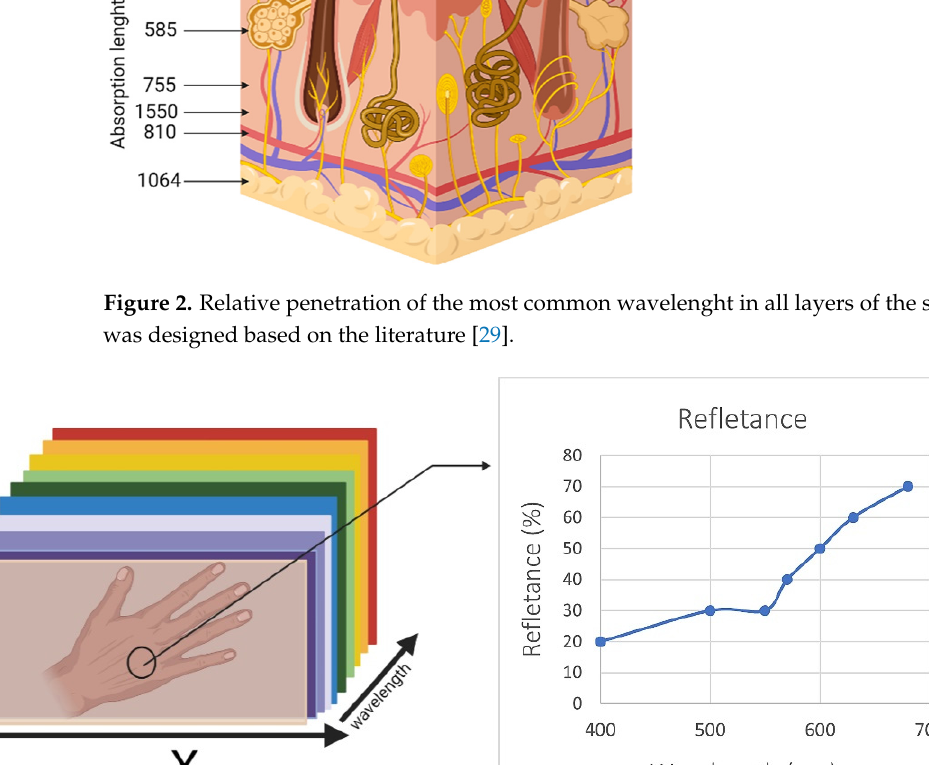
Figure 3. Hyperspectral skin image in the visible light range. This image was designed based on the literature [30].